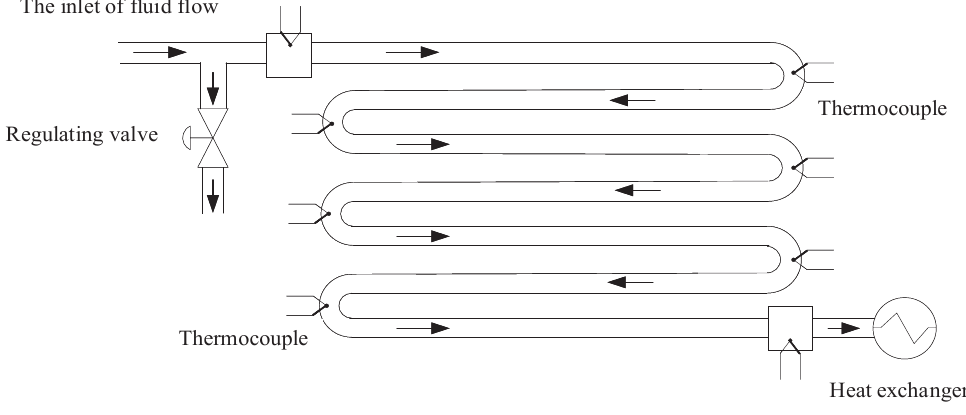
Figure 5. The sketch map of long duct heating